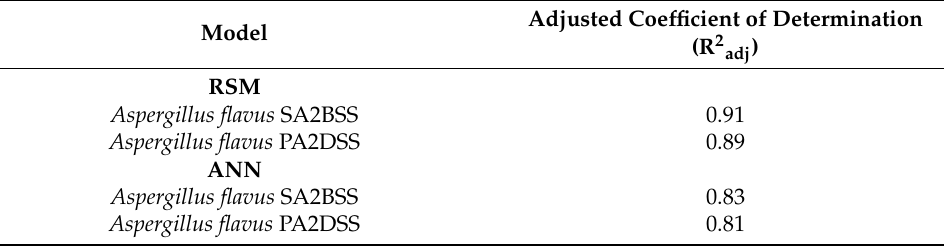
Table 12. RSM and ANN models comparison.